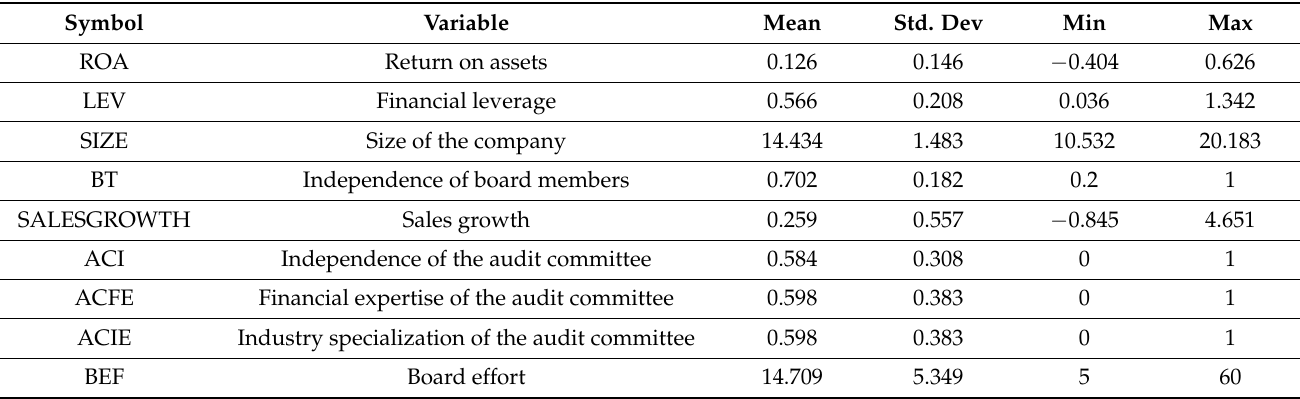
Table 3. Descriptive statistics of quantitative variables of the study.